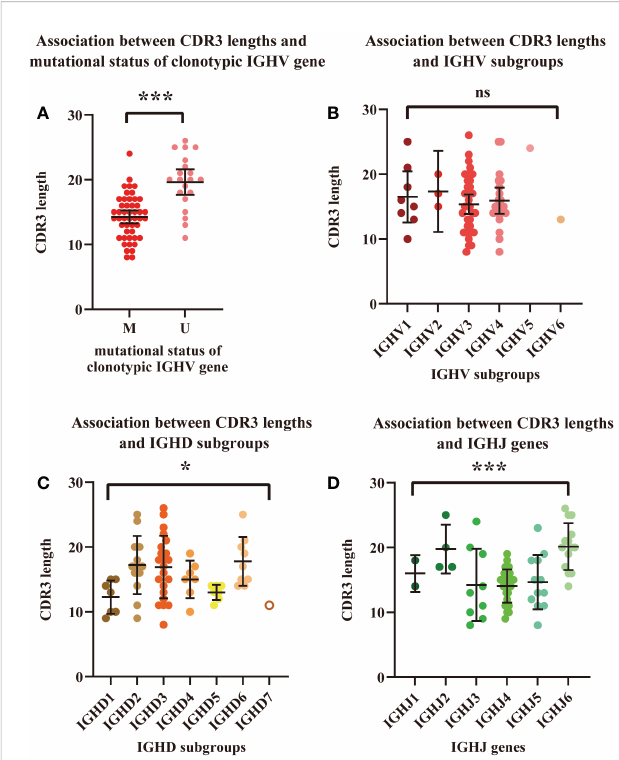
FIGURE 3 Association between HCDR3 length and mutational status of the clonotypic IGHV gene. (A) Association between HCDR3 length and IGHV mutational status. Red dots represent cases with mutated IGHV regions, and pink dots represent cases with unmutated IGHV regions. (B) Association between HCDR3 length and the IGHV subgroups used. (C) Association between HCDR3 length and the IGHD subgroups used. (D) Association between HCDR3 length and the IGHJ genes used. The statistical analysis was performed using Student ’ s t test, a <0.05 (two- sided). Ns, nonsigni fi cant. * P <0.05. *** P